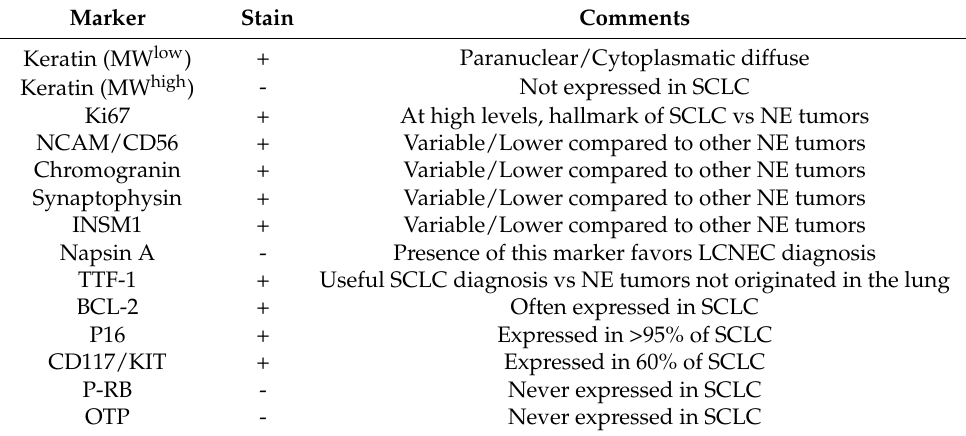
Table 1. Immunohistochemistry (IHC) markers and immunohistochemical characteristics of SCLC. Marker Stain Comments Keratin (MW low ) + Paranuclear/Cytoplasmatic